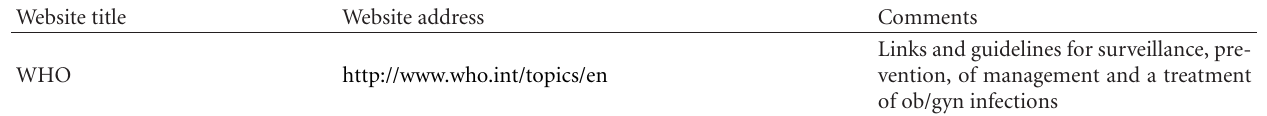
Table 1: World Wide Web resources on obstetrical and gynecological